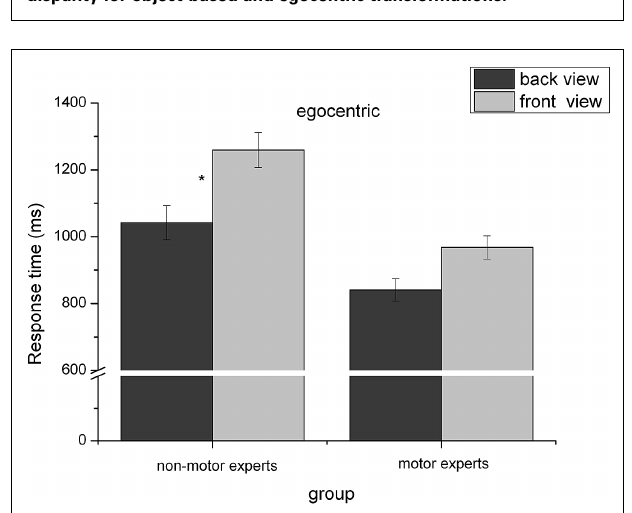
FIGURE 3 | Reaction time (mean and SE) dependent on view and angular disparity for the object-based transformations. * p < 0.05.